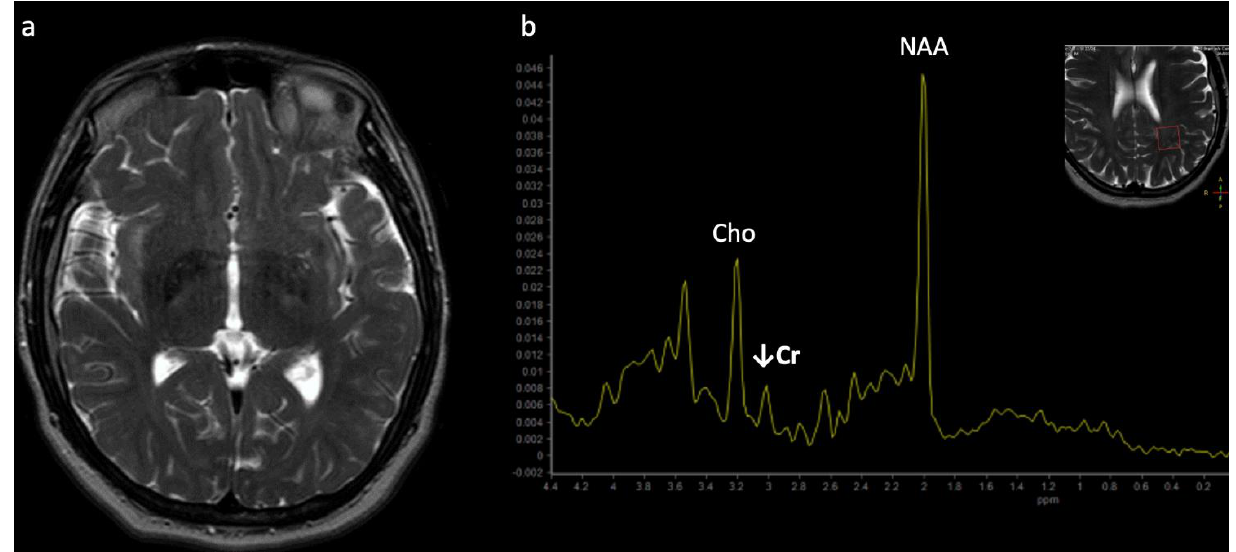
Figure 17. Twenty-year-old male with epilepsy and learning disability, with X-linked creatine transporter deficiency. ( a ) Axial T2WI of the brain is unremarkable. ( b ) SV short TE MRS over the left parietal white matter reveals Cr levels significantly below normal (~10 – 20% of normal at 3 and 3.9 ppm). NAA and Cho within normal limits.